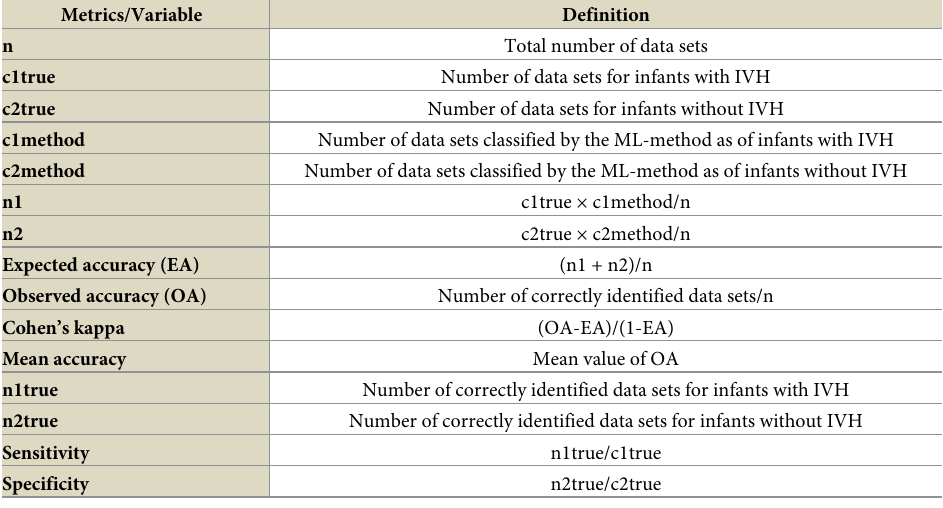
Table 4. Variables and metrics used in evaluation of model